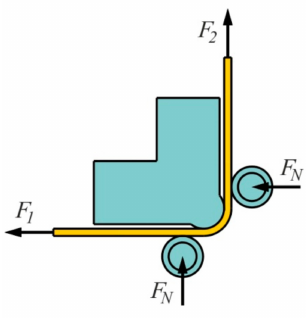
Figure 18. Schematic view of BUT device.